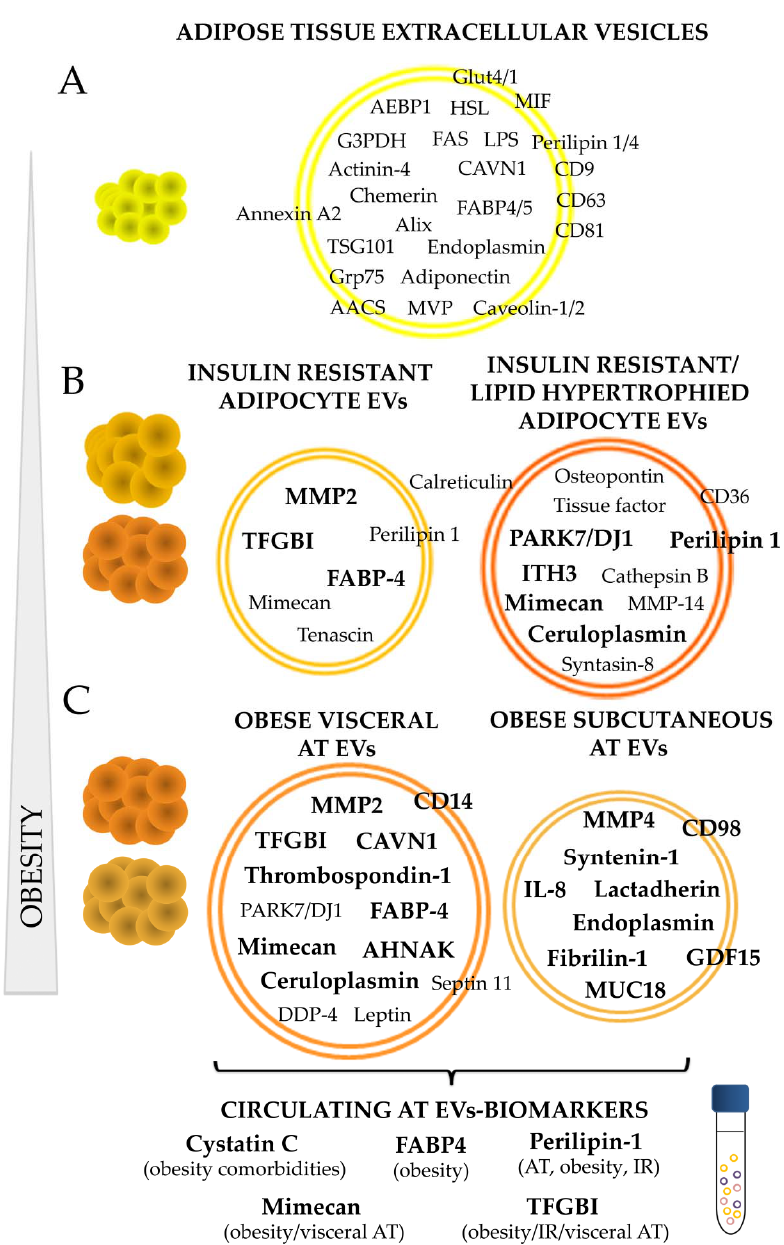
Figure 2. Adipose tissue EVs protein cargo and its alteration on the course of obesity. A summary of AT specific proteins described so far in the literature including those proteins present in EVs shed by normal / healthy adipocytes ( A ); those present or elevated with insulin resistance, lipid hypertrophied adipocytes ( B ); and those characteristic of subcutaneous and visceral human obese AT ( C ). Proteins in bold were found elevated compared to control healthy adipocytes, or compared to those released by adipose tissue of lean individuals. AT: adipose tissue; IR: insulin resistance; AEBP1: adipocyte enhancer-binding protein 1; HSL: hormone sensitive-lipase; FAS: fatty acid synthase; MVP: major vault protein; MIF: macrophage migration inhibitory factor; AACS: acetoacetyl-CoA synthetase; LPS: lipoprotein lipase; FABP: fatty acid binding protein; G3PDH: glyceraldehyde 3-phosphate dehydrogenase; CAVN1: caveolae associated protein 1; MMP: matrix metalloproteinase; ITH3: inter- α -trypsin inhibitor heavy chain H3; GDF15: growth di ff erentiation factor 15; IL: interleukin; MUC18: cell surface glycoprotein; AHNAK: neuroblast di ff erentiation-associated protein; TGFBI: transforming growth factor-beta-induced protein